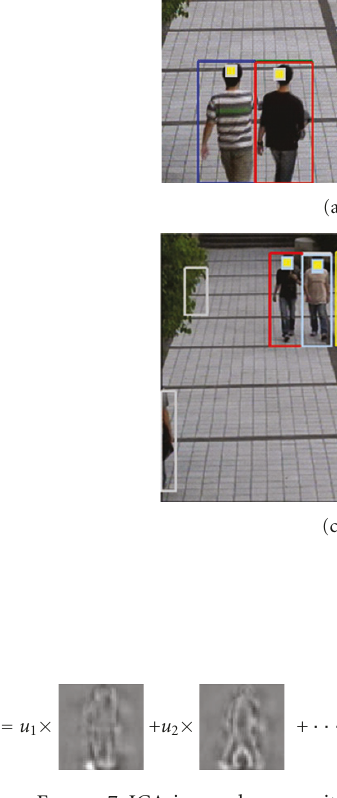
Figure 7: ICA-image